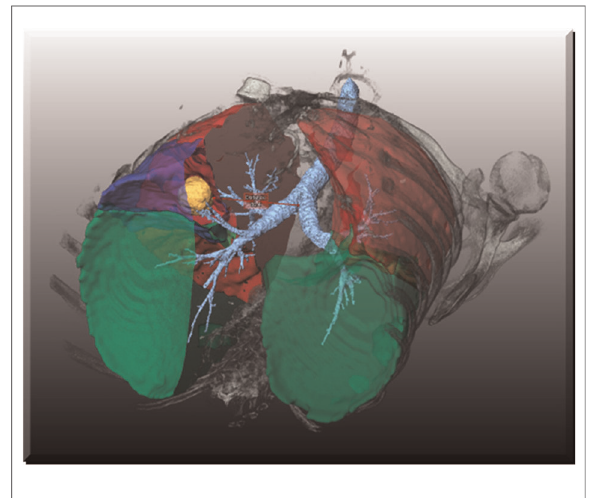
FIGURE 9 Visualization of segmented bronchi, lobe borders and tumor.